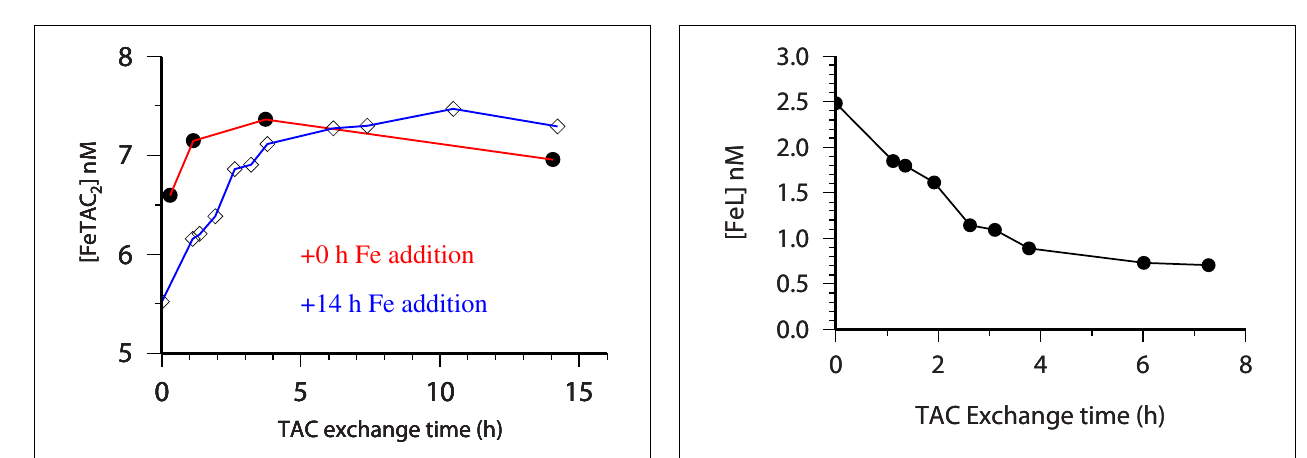
FIGURE 4 | CSV-KIN: time course of FeL (closed circles) concentrations as determined by mass balance from repeated CSV measurements over 8h. This data is used for the determination of k d .The samples had been equilibrated with Fe for 14h prior to the addition ofTAC.Water sample is from 60m at Station 28 (see Table 1 for more details) during the Meteor 55